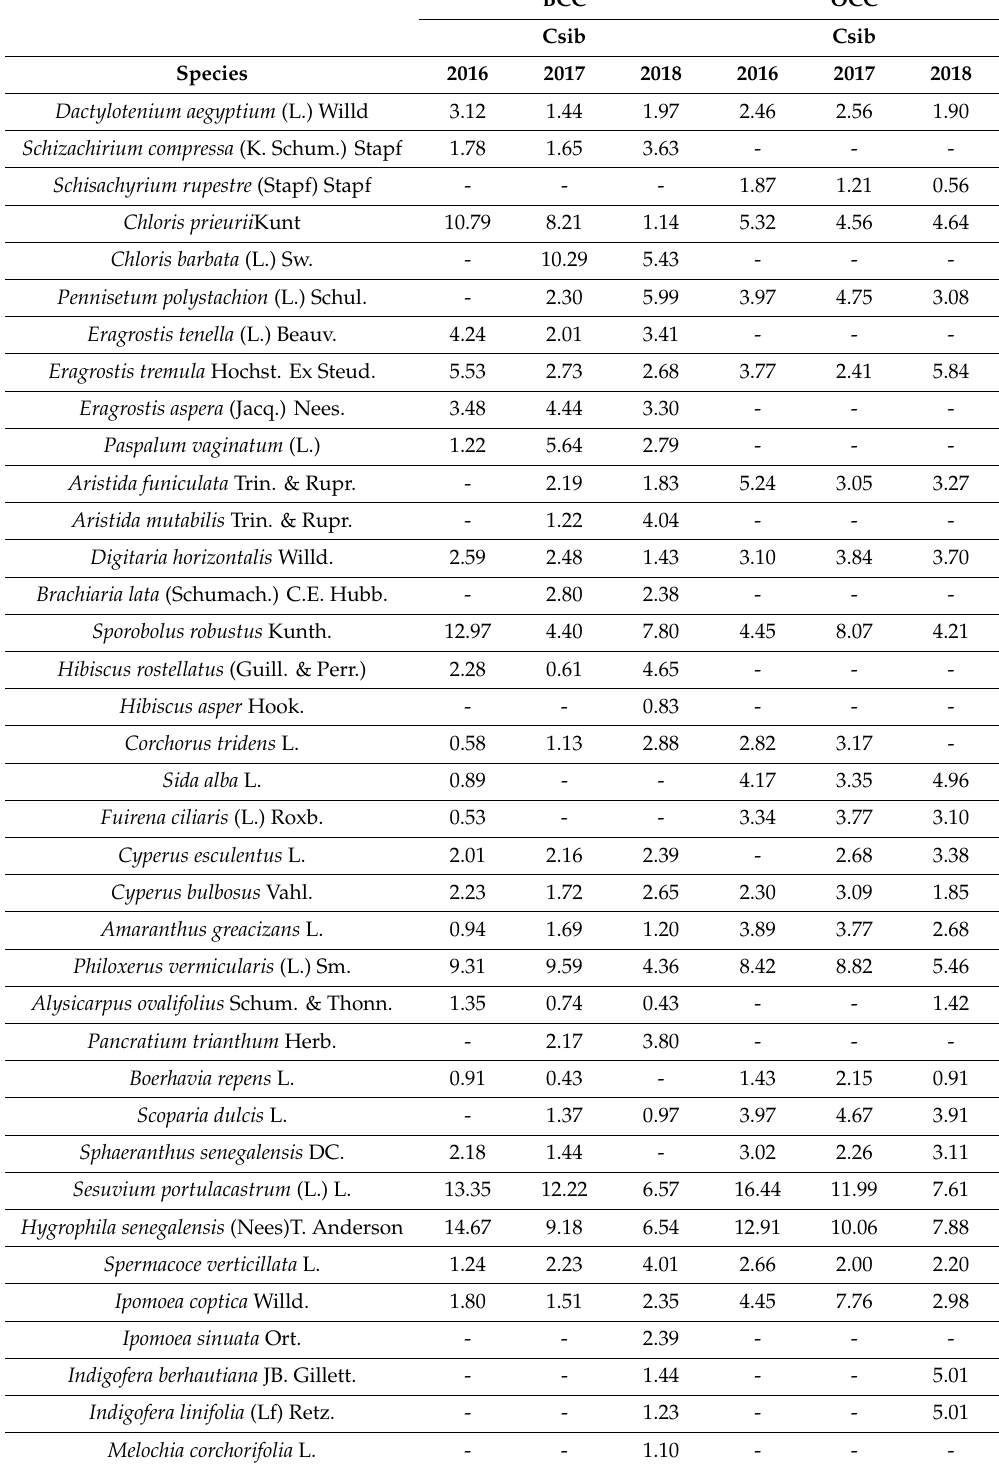
Table 5. Specific contribution dry biomass (Csib) below (BCC) and outside the Casuarina canopy (OCC).